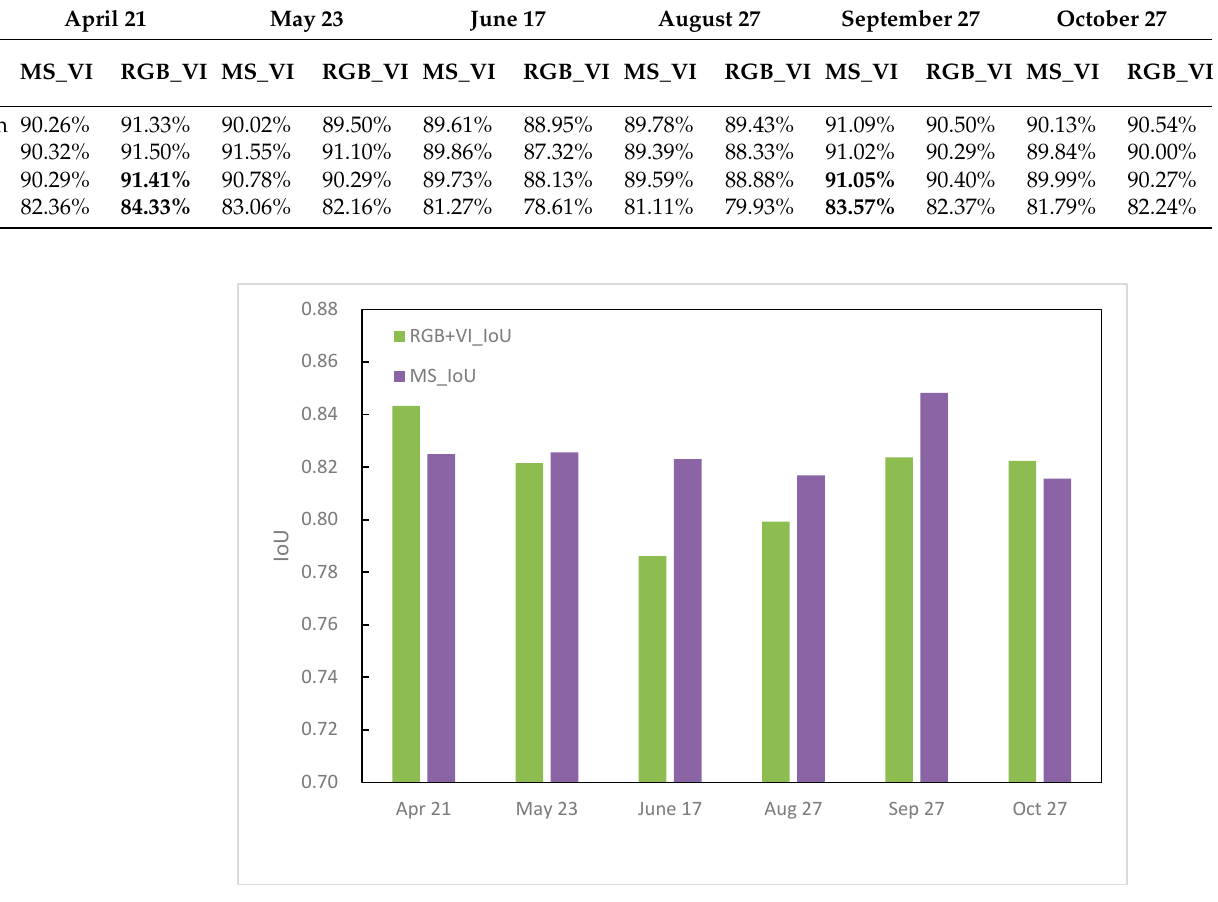
Table 5. Accuracy of the model with added vegetation indices (VIs) in di ff erent months. For MS and RGB imagery, the highest IoU and F1 are highlighted in bold.